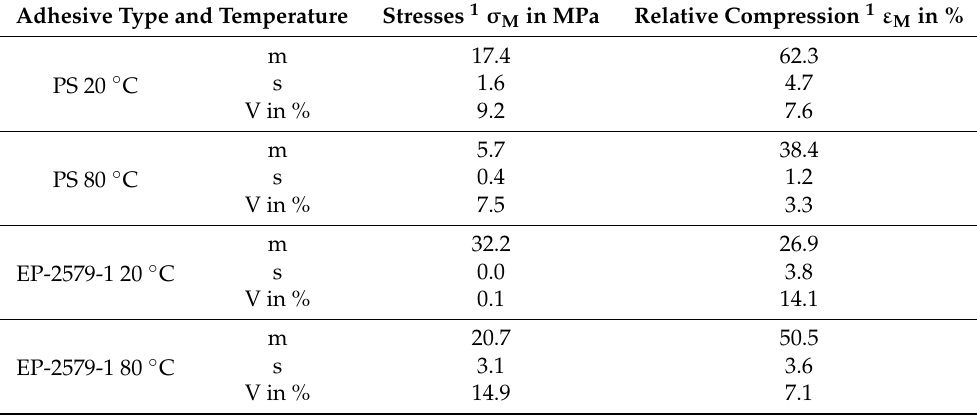
Table 3. Results for uniaxial compression test at 20 ◦ C and 80 ◦ C.